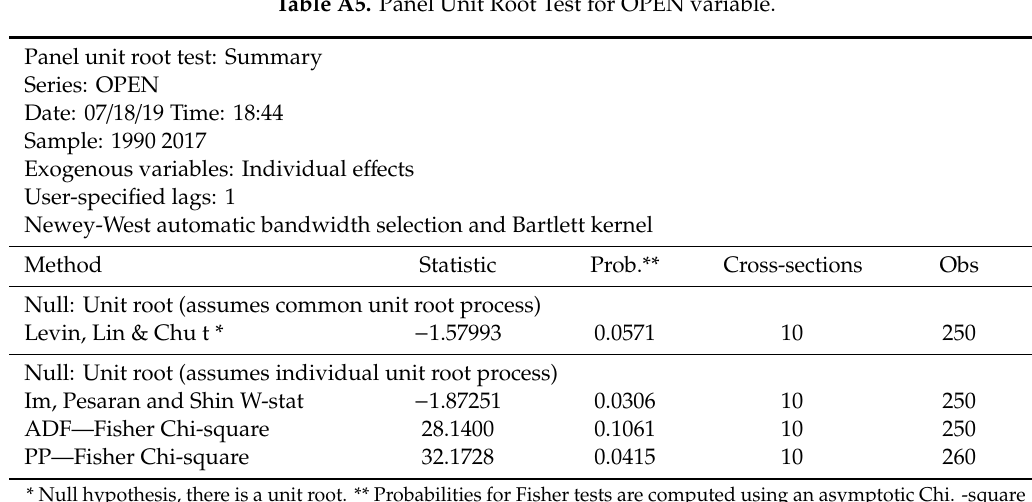
Table A5. Panel Unit Root Test for OPEN variable.